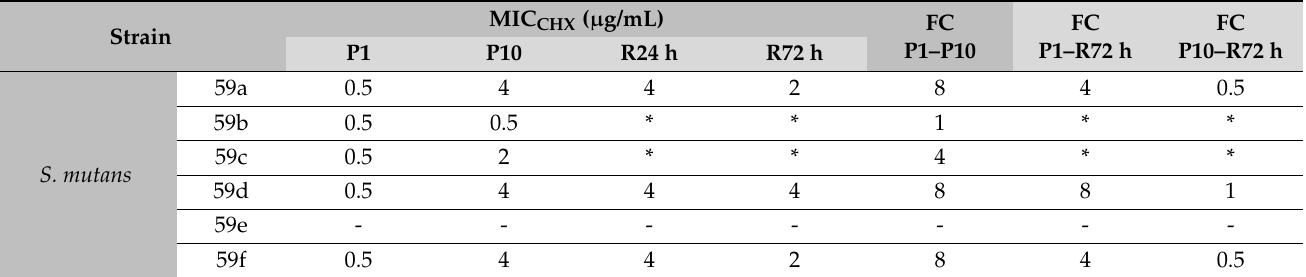
Table 3. Isolates exhibiting at least 8-fold MIC increase toward CHX between P1 and